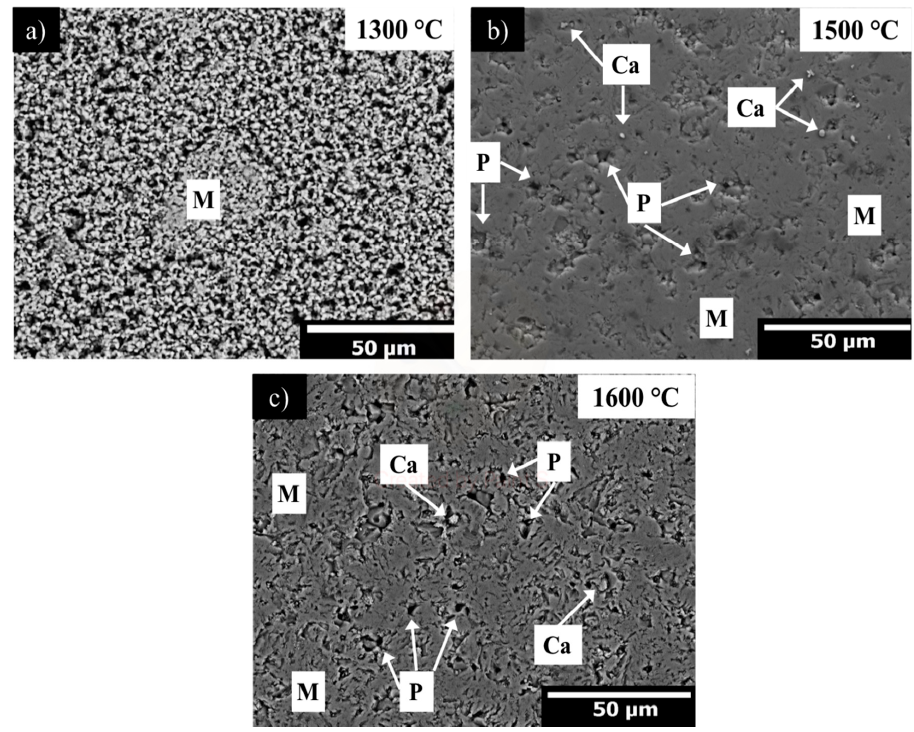
Figure 5. SEM micrograph in back-scattered electron image mode corresponding to a typical microstructure of magnesia, sintered at ( a ) 1300 °C, ( b ) 1500 °C, and ( c ) 1600 °C. Where, M = magnesia, Ca = CaO, P = porosity. Materials 2020 , 12 , x FOR PEER REVIEW